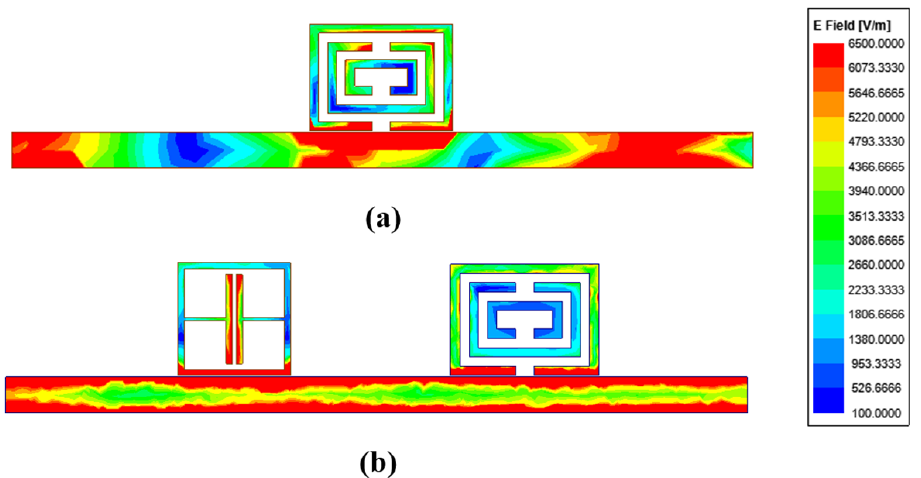
Figure 4. Electric field distribution of chipless RFID tags at resonance peak frequencies: ( a ) proposed CSRR resonator (2.95 GHz); ( b ) ELC resonator (3.95 GHz) and proposed CSRR resonator (3.26 GHz).